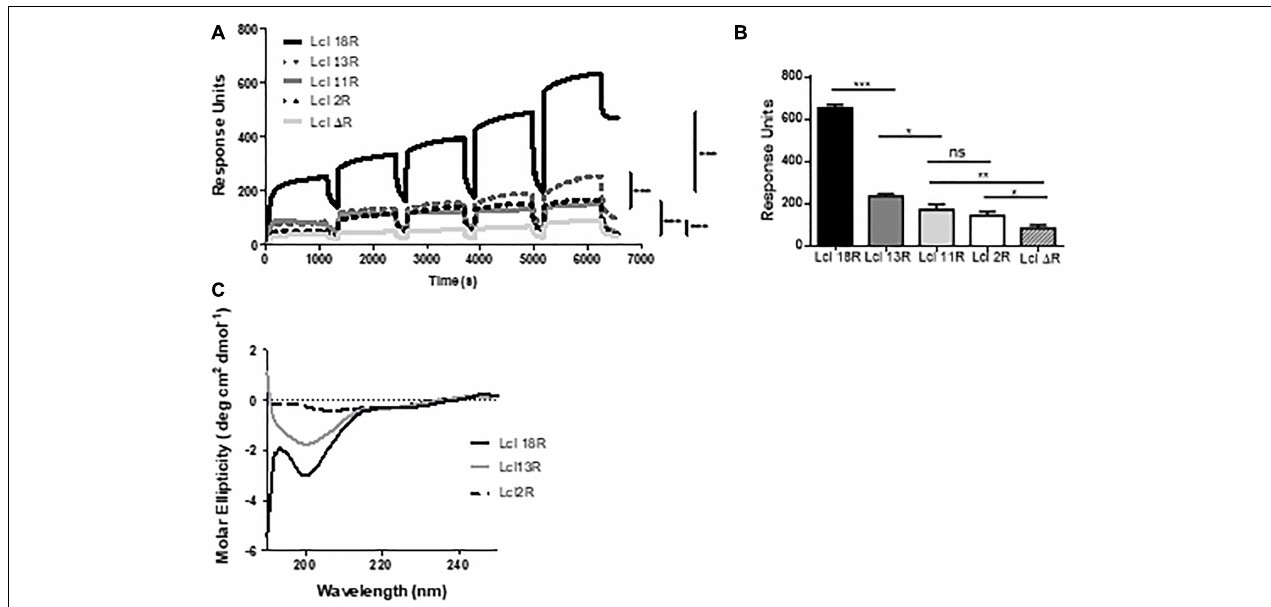
FIGURE 9 | The binding affinity of Lcl increases with the number of collagenous repeats. (A,B) Surface plasmon resonance sensorgrams for single-cycle injection analysis of the interaction between His-tagged Lcl with 18 repeats (Lcl 18R), His-tagged Lcl with 13 repeats (Lcl 13R), His-tagged Lcl with 2 repeats (Lcl 2R), and His-tagged Lcl with 0 repeats (Lcl (cid:49) R) against GST-tagged Lcl immobilized on anti-GST modified Biacore TM sensor chips. (B) Calculated K D between His-tagged Lcl 18R, His-tagged Lcl 13R, His-tagged Lcl 11R, His-tagged Lcl 2R, and His-tagged Lcl (cid:49) R measured by Surface plasmon resonance to fucoidan at a concentration of 500 µ M. (C) Circular dichroism profiles of Lcl 18R, Lcl 13R, Lcl 2R, and Lcl (cid:49) R. Plotted values are the average of 3 individual experiments. ∗ , ∗∗ , and ∗∗∗ denotes p < 0.05, 0.01, and 0.001, respectively, using one-way ANOVA. Experiments were performed in